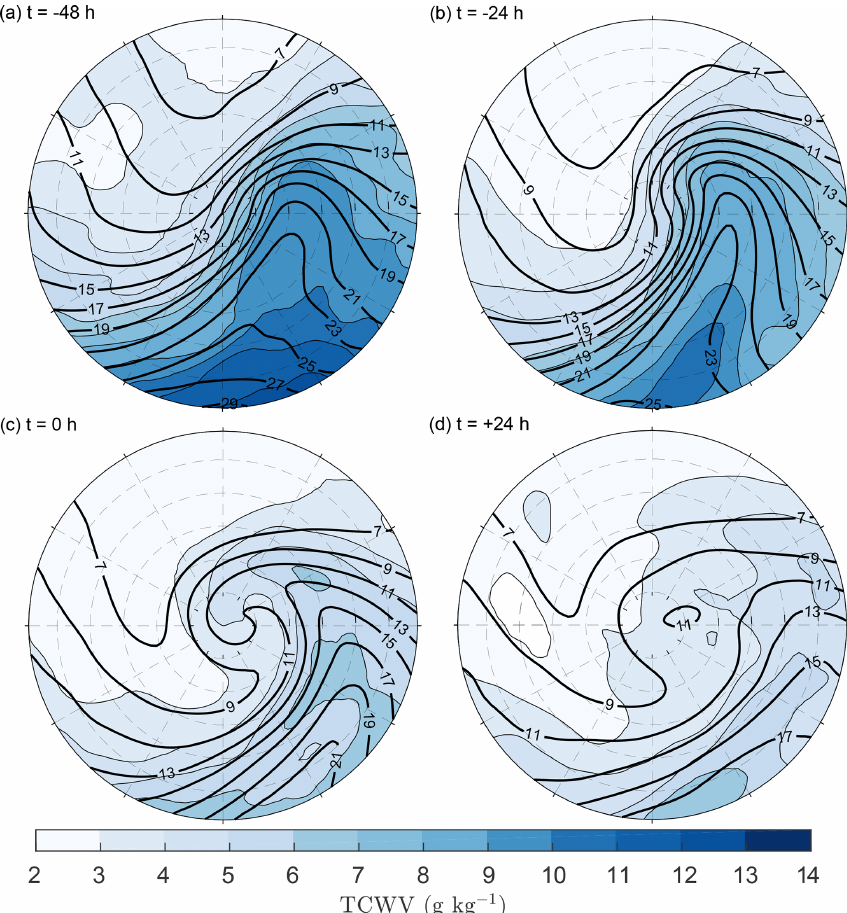
Figure 8. Composite mean of the total column water vapour (TCWV) of the strongest 200 extra-tropical cyclones in the CNTL simulation (black contours, every 2gkg − 1 ) and the difference between SST4 and CNTL (shading) at (a) 48h before time of maximum intensity, (b) 24h before time of maximum intensity, (c) time of maximum intensity, and (d) 24h after the time of maximum